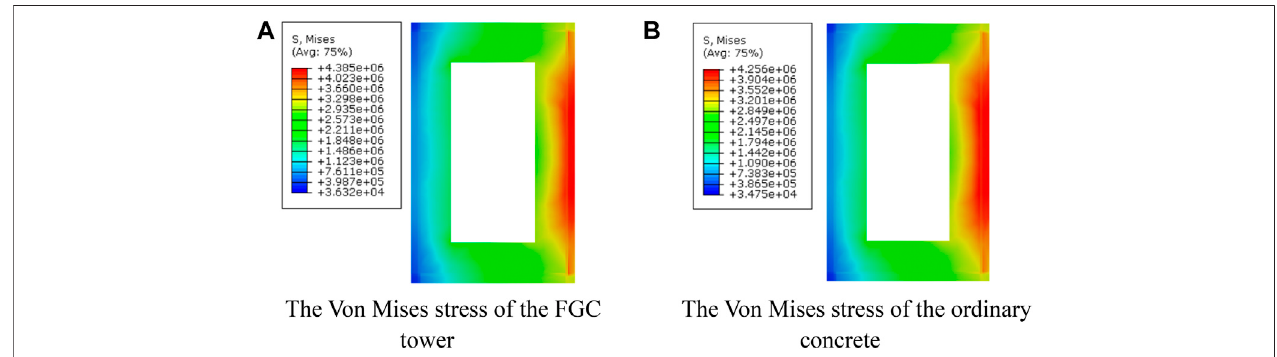
FIGURE 9 | The Von Mises stress at the transition section of the upper tower and the middle tower due to the dead and gradient temperature loads. (A) The Von Mises stress of the FGC tower. (B) The Von Mises stress of the ordinary concrete.